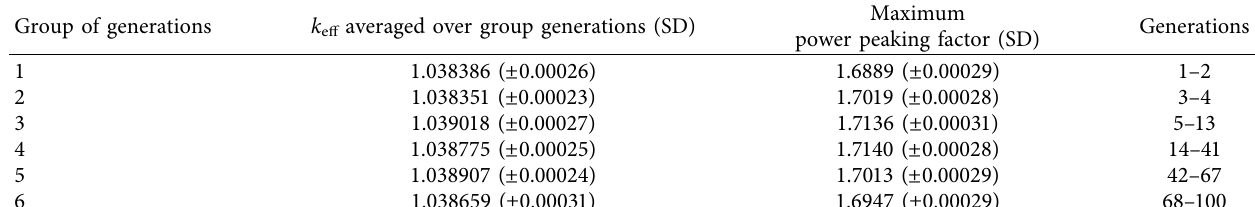
Table 6: Group generations having the same optimal k